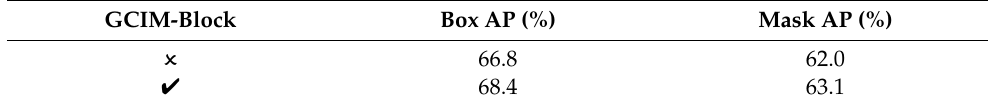
Table 4. Quantitative Results with and Without GCIM-Block.